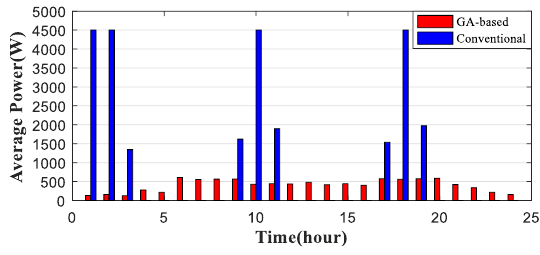
Figure 9. Comparison of EWH power consumption solution.